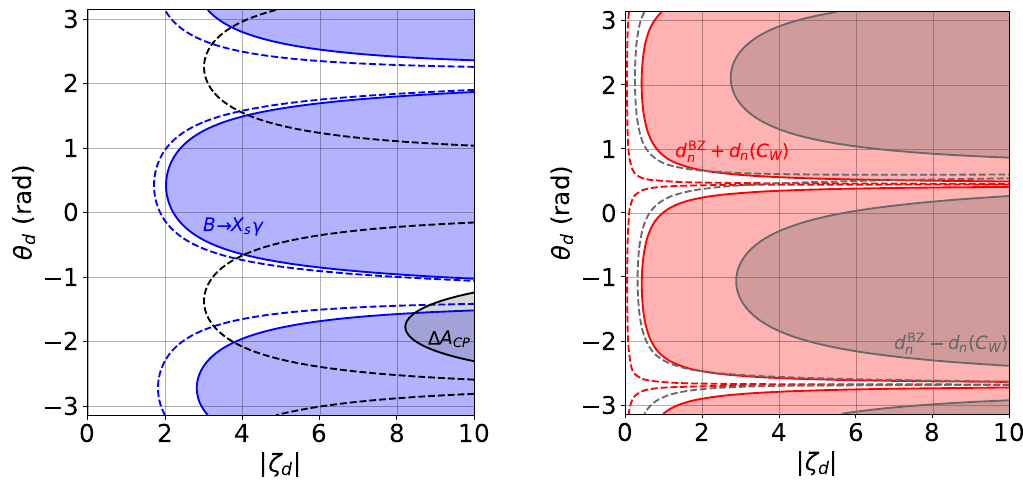
Figure 8 . The constraints on | ζ d | - θ d plane at the BP1 from the flavor (left) and nEDM (right) experiments. The blue (black) shaded regions in the left panel are the excluded regions from B → X s γ ( ∆ A CP ). The red (gray) regions in the right panel are excluded by the current nEDM experimental data when the Weinberg operator positively (negatively) contributes to the nEDM. The dashed lines in each panel are future expected